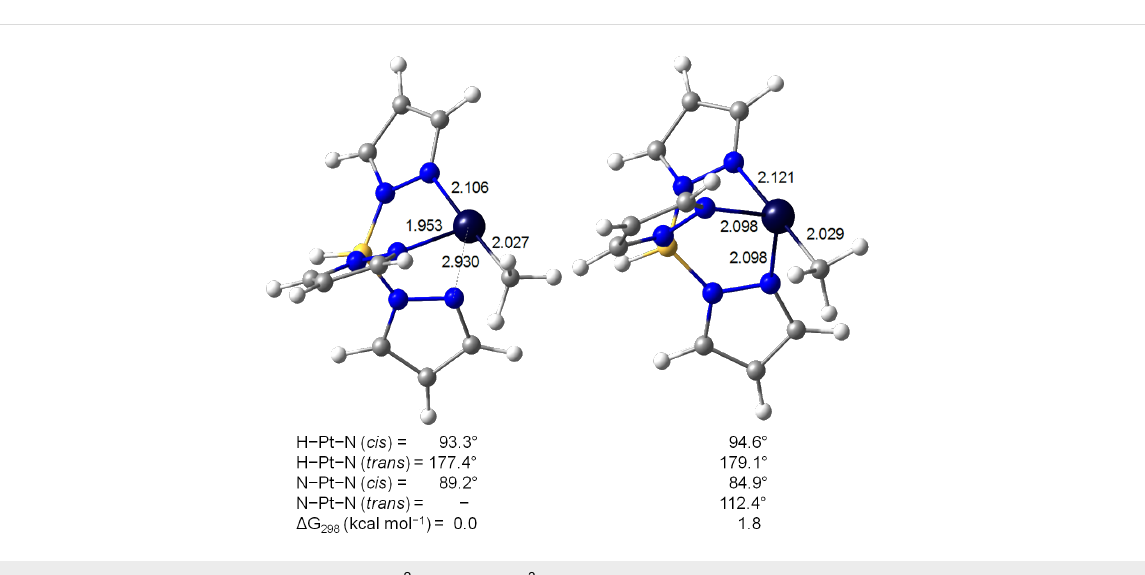
Figure 18: DFT-optimized structures describing the κ 2 ( 69 , left) and κ 3 ( 69’ , right) coordination modes of [Pt(Me)Tp] [139]. Bond distances in angstroms, angles in degrees and Gibbs energies in kcal mol − 1